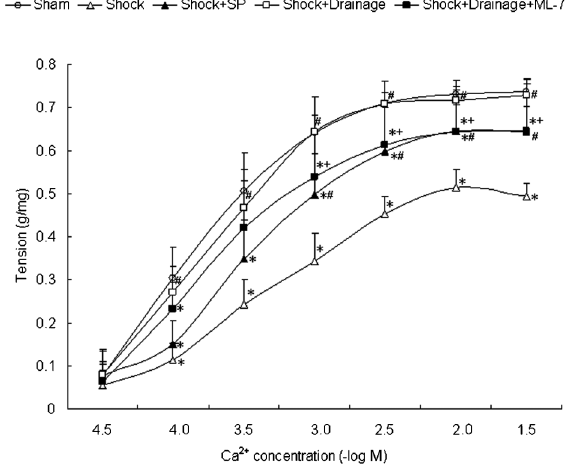
Figure 3. Myosin light chain kinase increases vascular calcium sensitivity on post-shock mesenteric lymph drainage in hemor- rhagic-shock rats. Data are reported as means±SD (n=6). SP: substance P, an agonist of MLCK; ML-7: an inhibitor of MLCK.